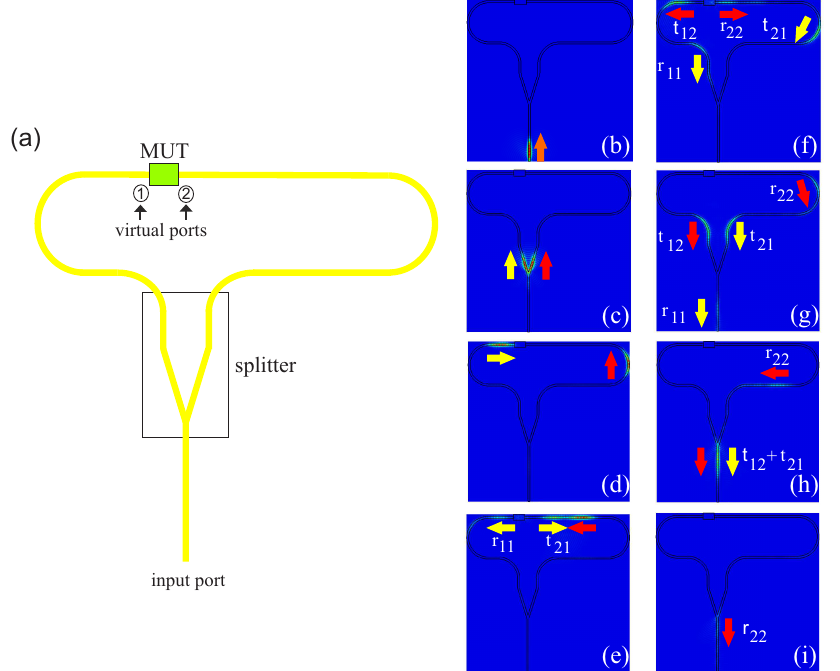
Figure 5. ( a ) shows the schematic structure. ( b – i ) illustrate the signal step by step using field recordings at different